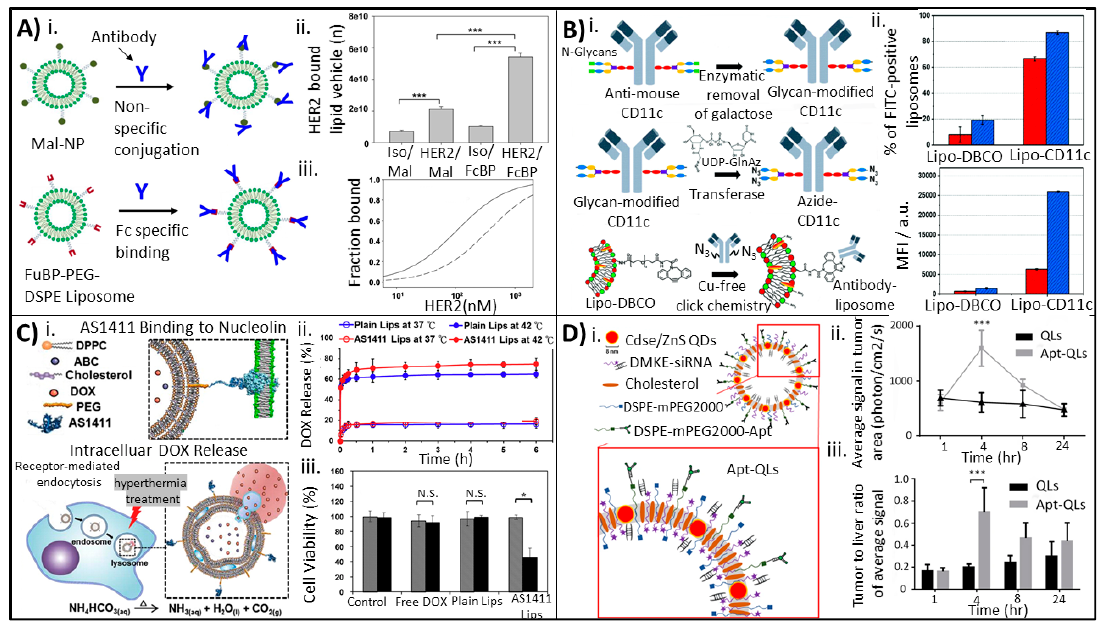
Figure 5. Bioconjugation strategies using antibodies and aptamers for improved drug targeting and delivery. ( A ) ( i ) Schematic of antibody orientation on maleimide-PEG-DSPE NPs versus Fc-specific binding onto Staphylococcus aureus and FcBP-PEG-DSPE NPs. Antibodies bind nonspecifically to Mal-NPs while Fc-specific binding leads to oriented control in S. aureus . Conjugation of FcBP to liposome surface allows for controlled orientation of antibodies on engineered NPs. ( ii ) Quantification of HER2 bound to the fluorescent liposome. NPs with the HER2 antibody had significantly increased binding versus NPs with the control IsoIgG antibody (*** p < 0.05) and HER2 / FcBP-NPs had significantly increased binding versus HER2 / Mal-NPs. ( iii ) Microscale thermophoretic binding curves for HER2 / Mal-NPs and HER2 / FcBP-NPs versus concentration of the HER2 protein. Dotted line denotes HER2 / Mal-NP, solid line denotes HER2 / FcBP-NP. Image adapted from Shim © Elsevier (2019) Ref. [86]. ( B ) ( i ) Schematic of antibody functionalization and attachment via copper-free click chemistry to DBCO-surface modified liposomes. ( ii ) Confirmed antibody presence on the liposome surface. FITC-labeled secondary antibody was allowed to attach to DBCO and CD11c-conjugated liposomes under two di ff erent reaction conditions (blue versus red bars). Flow cytometry confirmed significantly higher presence of FITC labeling on CD11c-liposomes. Legend for both images: red denotes DBCO:NH 2 = 1:1, blue denotes DBCO:NH 2 = 3:1. Image adapted from Gai © Royal Society of Chemistry (2020) Ref. [87]. ( C ) ( i ) Schematic of the thermoresponsive AS1411 liposome with encapsulated doxorubicin and ABC, and its mechanism of nucleolin binding via AS1411 targeting and hyperthermia-induced intracellular doxorubicin release. ( ii ) Doxorubicin release of AS1411 liposomes suspended in aqueous media at body temperature (37 ◦ C) or hyperthermic temperature (42 ◦